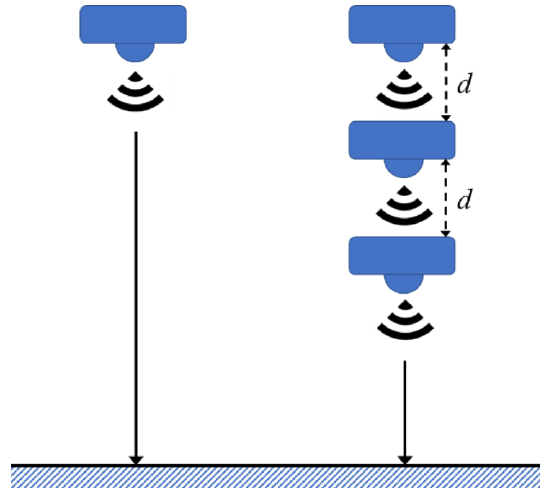
Figure 1. Single sensing and multi-step sensing